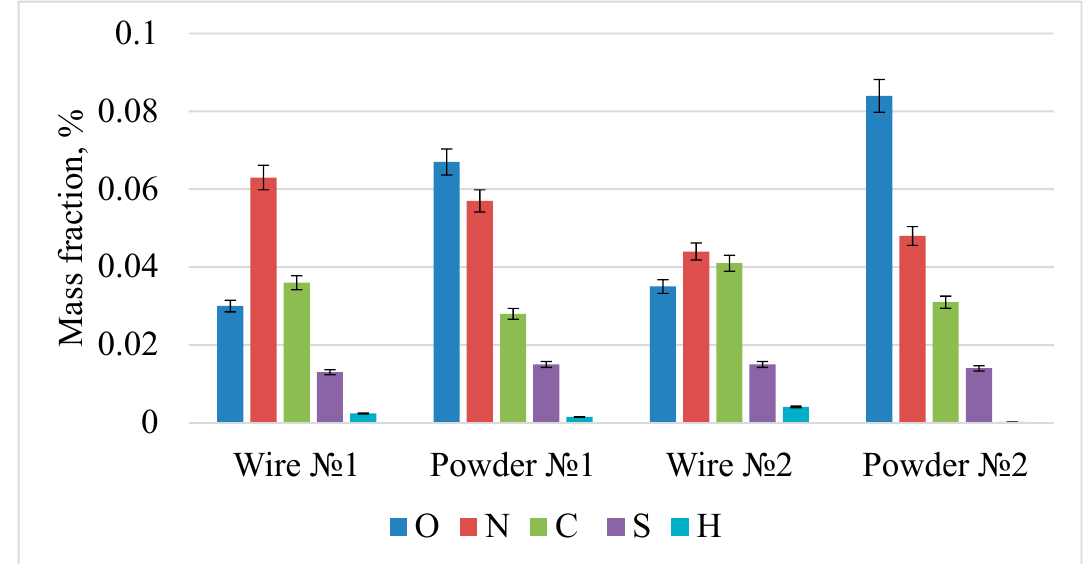
Figure 10. The results of the analysis of the impurity composition of samples 1 and 2.